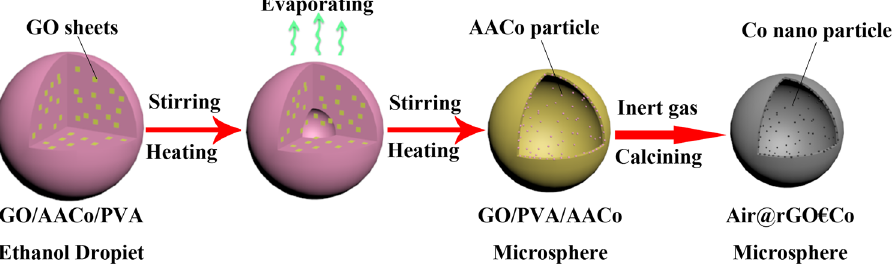
Figure 1. A schematic illustration for the self-assembly process of Air@rGO€Co microspheres.